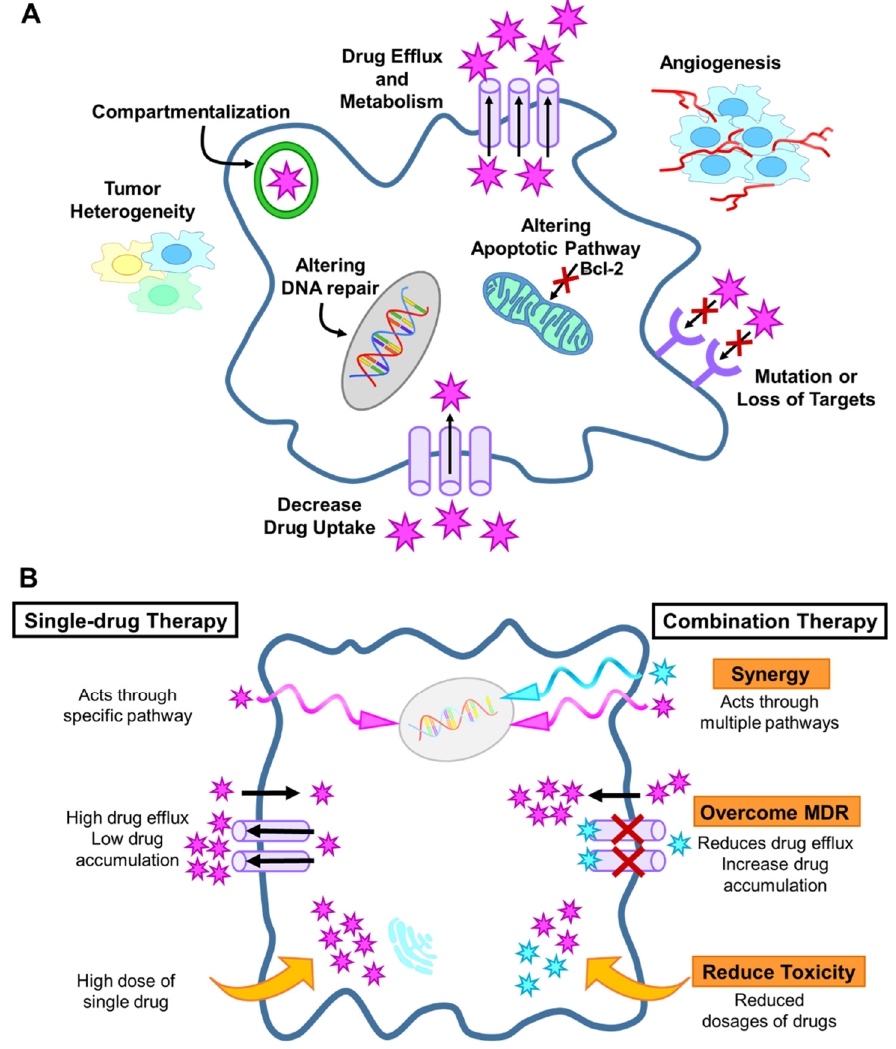
Figure 1. ( A ) Overview of mechanisms affecting cancer cell resistance to anticancer therapy rang- ing from changing protein expression to effecting drug accumulation, drug metabolism, to repair of apoptotic pathways. ( B ) Advantages of drug combination for treating ovarian cancer. Synergy can be observed when the drug combinations act through multiple pathways. Combinations can overcome multi-drug resistance (MDR) mechanisms to increase anticancer activity. Delivery of drug combinations can also reduce toxicity by reducing the required doses of each